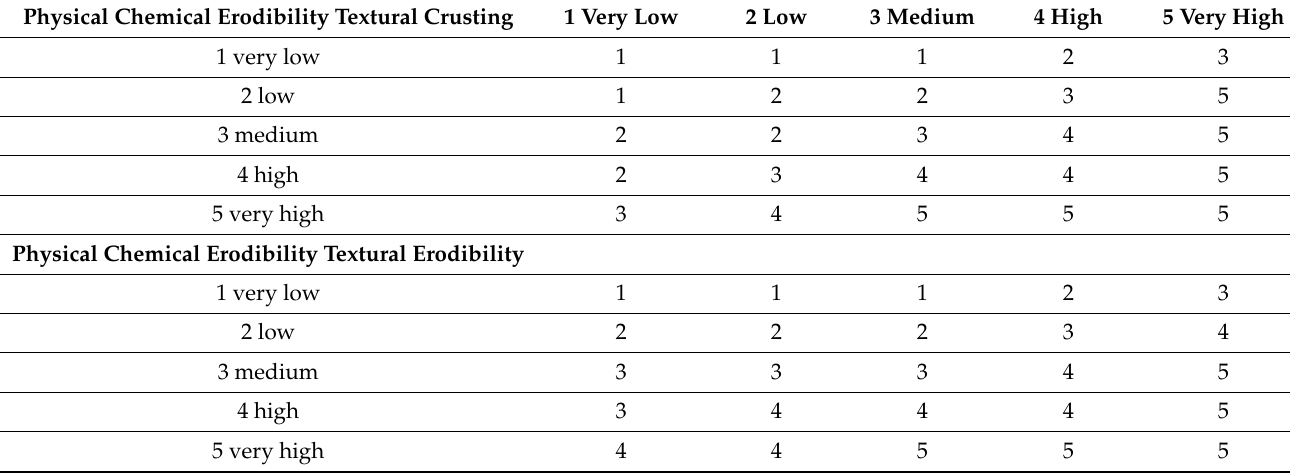
Table A2. Assessment of soil crusting and soil erodibility by the combination of physical–chemical and textural crusting parameters and textural erodibility parameters, respectively